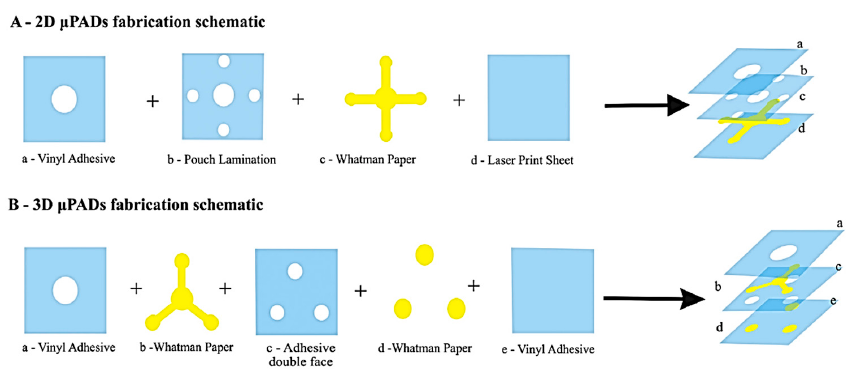
Figure 8. Fabrication of 2D and 3D μ PADs through vinyl cutter (Adapted with the permission from Elsevier) [57].